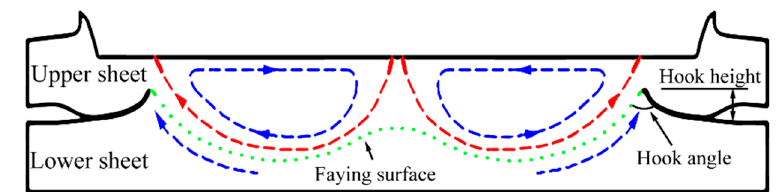
Figure 6. Schematic illustrations of the material fl ow during P-FSSW with a flat tool.